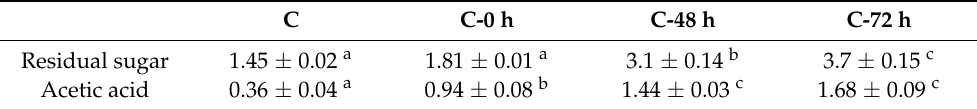
Table 3. Residual sugar and acetic acid content (g/L) in wines obtained by single strain EC1118 in fermentations added with acetic acid. The acetic acid was added at different times, at the beginning (C-0 h), after 48 h (C-48 h) and after 72 h (C-72 h) in comparison with samples without acetic acid addition (C). For each compound, different superscript letters mean significant differences (Tukey’s test, p ≤ 0.05) among wines produced by single strain EC1118 in fermentations with and without acetic acid addition. Data are expressed as mean ± standard deviation of two replicates. C C-0 h C-48 h C-72 h Residual sugar 1.45 ± 0.02 a 1.81 ± 0.01 a 3.1 ± 0.14 b 3.7 ± 0.15 c Acetic acid 0.36 ± 0.04 a 0.94 ± 0.08 b 1.44 ± 0.03 c 1.68 ± 0.09